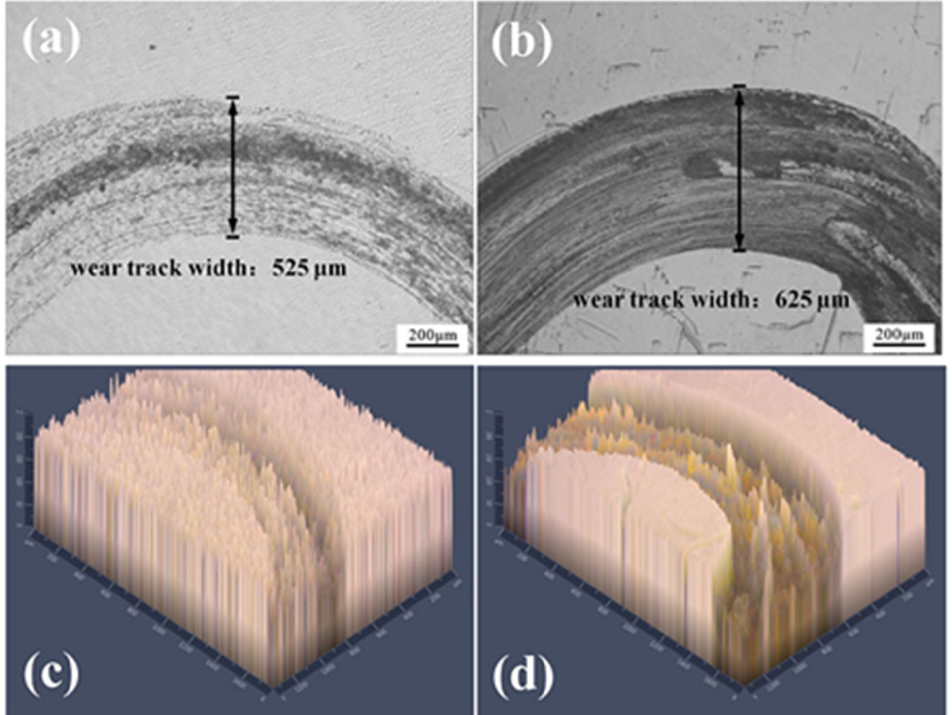
Figure 17. Three-dimensional microscopic analysis of the worn surfaces of the SLD coating ( a , c ) and the LC coating ( b , d ) SLD coating [95].